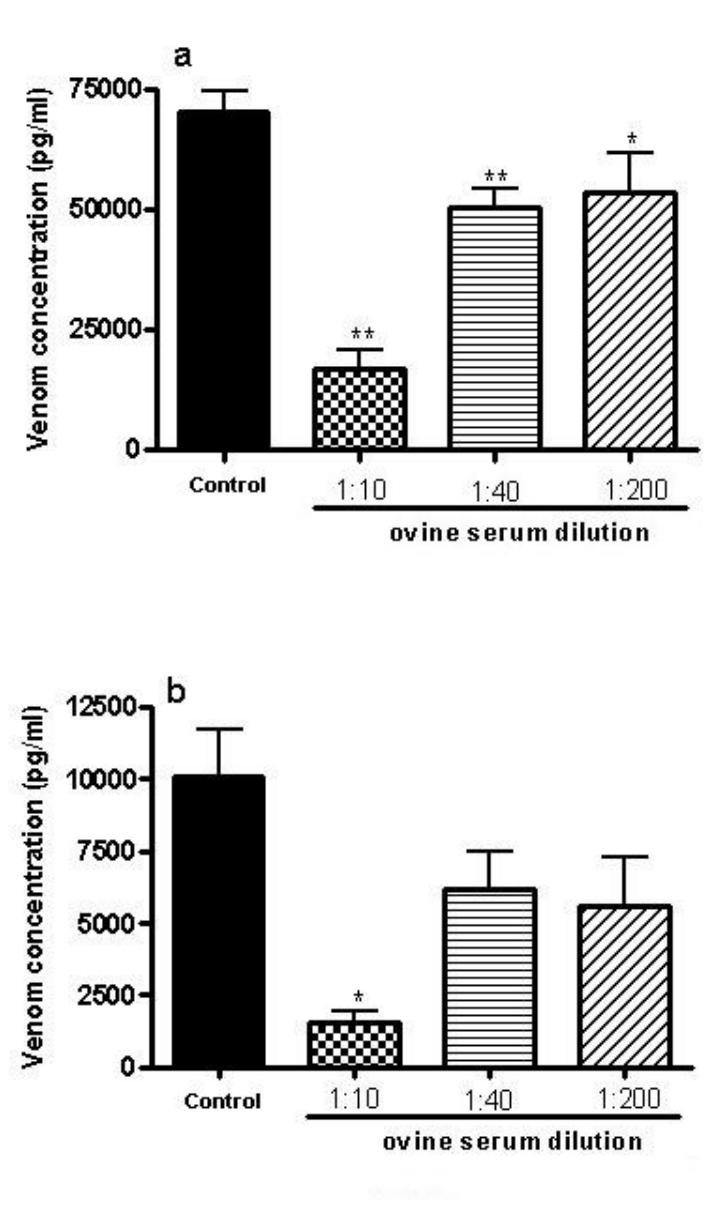
Figure 2: In vivo neutralizing activity of ovine antibothropic serum. Swiss mice were of B. jararaca venom by IP route. After 15 min, animals were treated injected with 1 LD 50 with ovine antibothropic serum (diluted 1:10, 1:40, or 1:200). A group was left untreated and used as a control. Biological samples were obtained 6 hours after venom inoculation and analyzed for their venom concentration by ELISA. Venom concentrations in blood (a) and spleen homogenate (b) samples. Values are means ± SD. *p<0.05 and **p<0.01 regarding the untreated